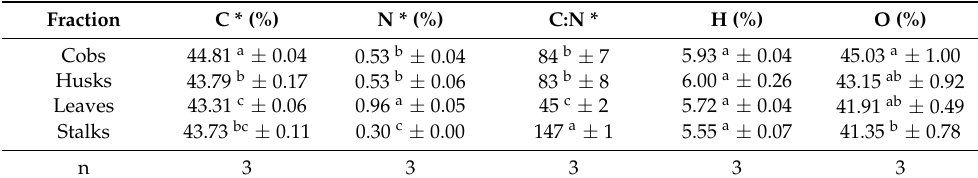
Table 1. Chemical composition of maize stover